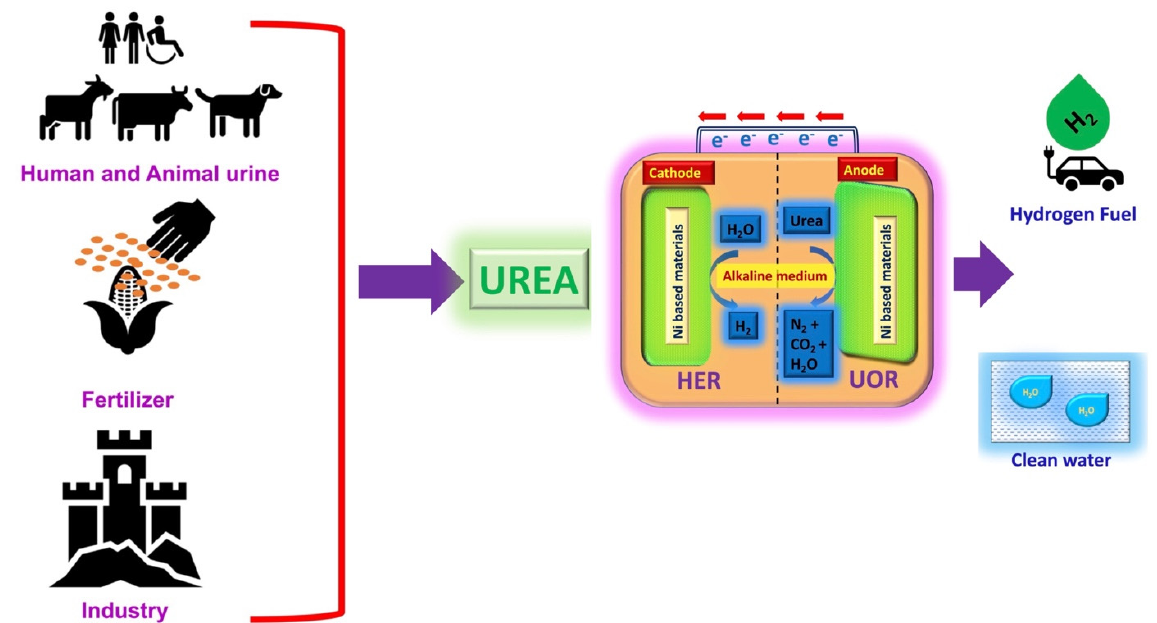
Figure 1. Schematic illustration of urea electrolysis for H 2 generation and the sources of urea.